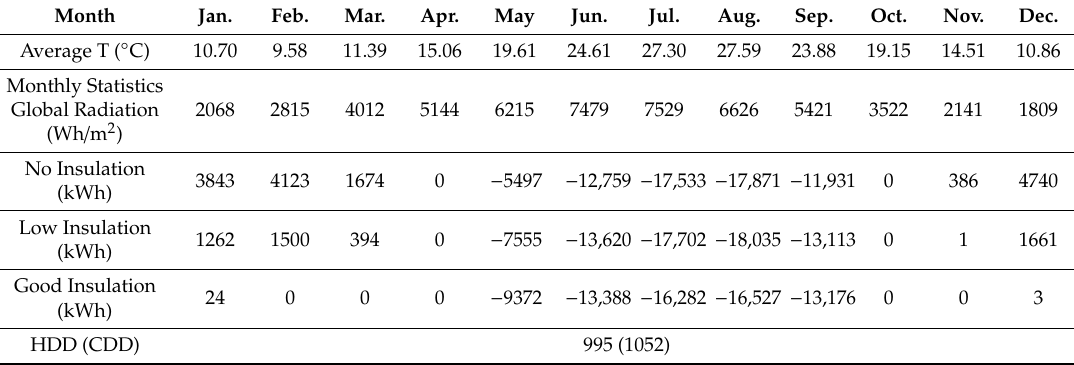
Table 3. Average monthly climatic data and energy demand of